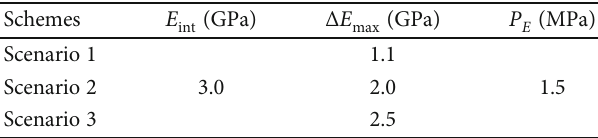
Figure 28: Distribution of CO pressure along the section A-B. 2 Table 6: The schemes of investigation on the e ff ect of coal weakening on CO 2